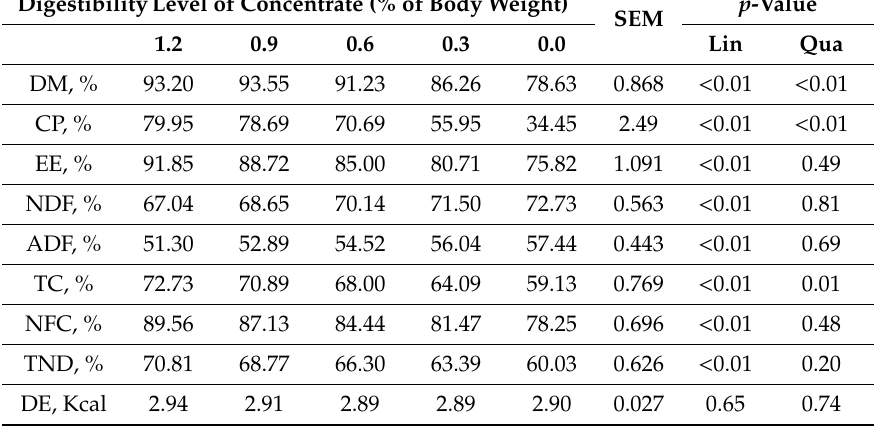
Table 2. Apparent digestibility of dry matter (DM) and nutrients of Pantaneira cow breed, fed with di ff erent levels of